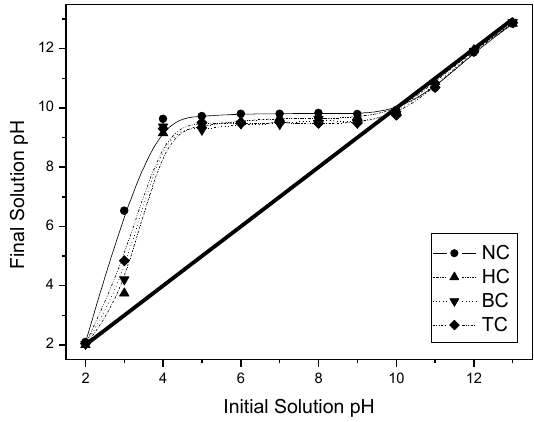
Figure 1. Determination of the Point Zero Charge of the natural and modified clays.